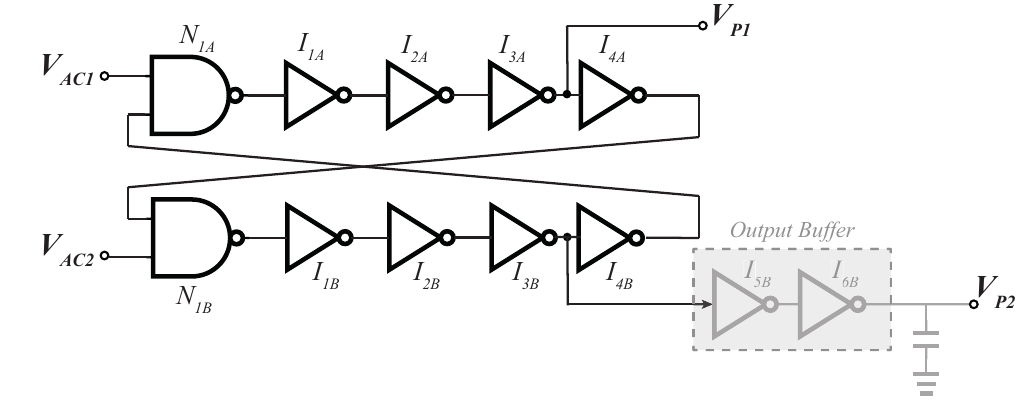
Figure 8. Non-overlapping phases generator